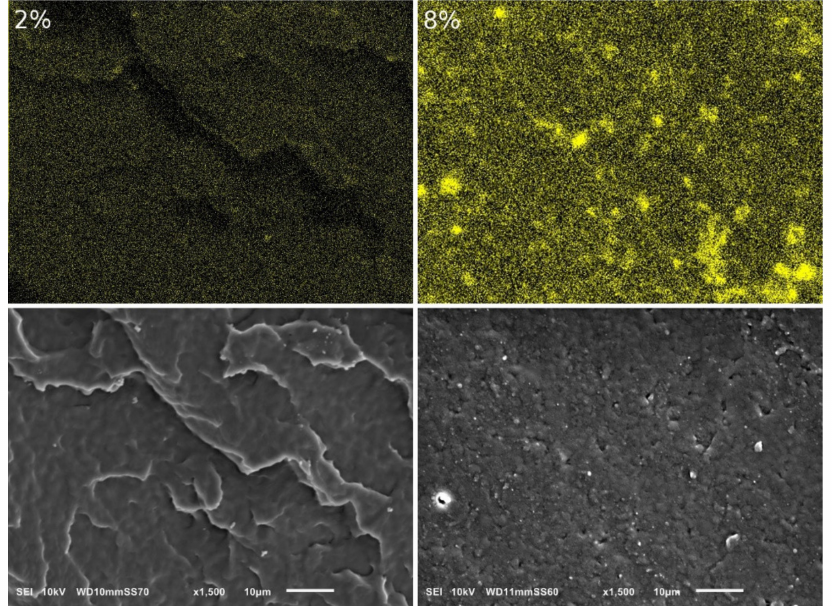
Figure 1. SEM images for two selected blends with 2 and 8 wt% POSS (bottom row) and correspond- ing energy dispersive X-ray spectroscopy (EDX) mapping at the spectral line of silicon (top row). The scale bar corresponds to 10 µ m.